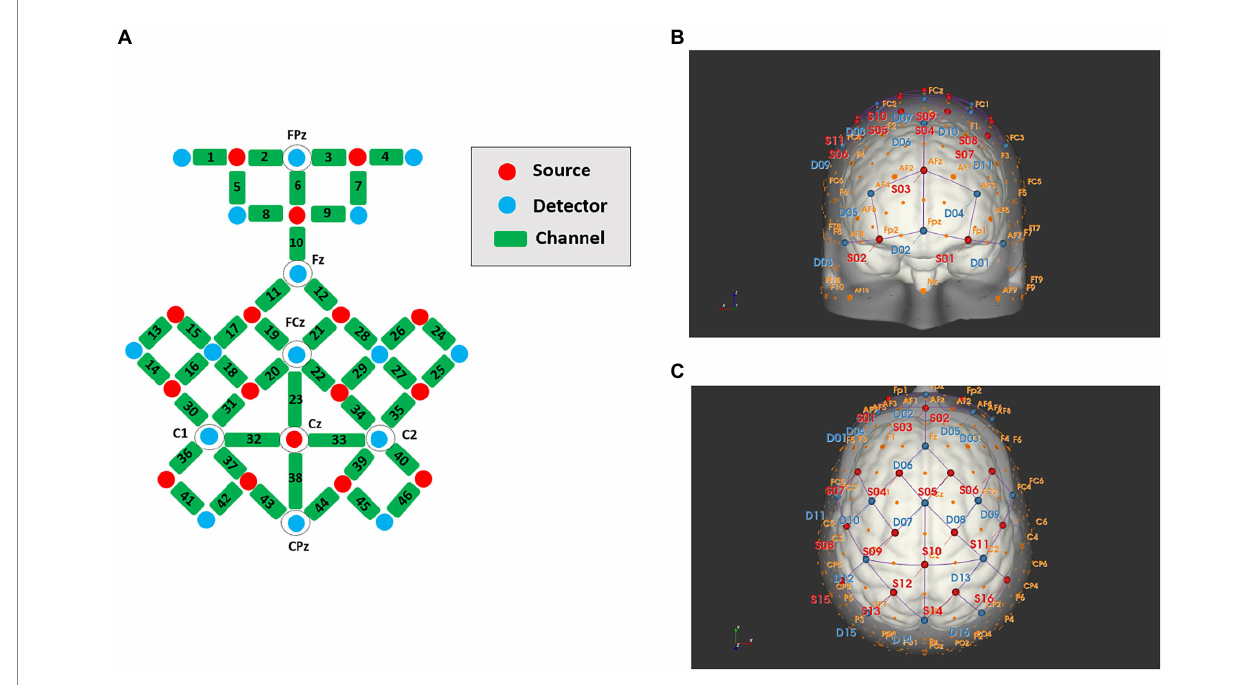
FIGURE 1 Schematic diagrams of the source, detector, and channel locations, (A) channel planimetric map; (B) front view; (C) plan